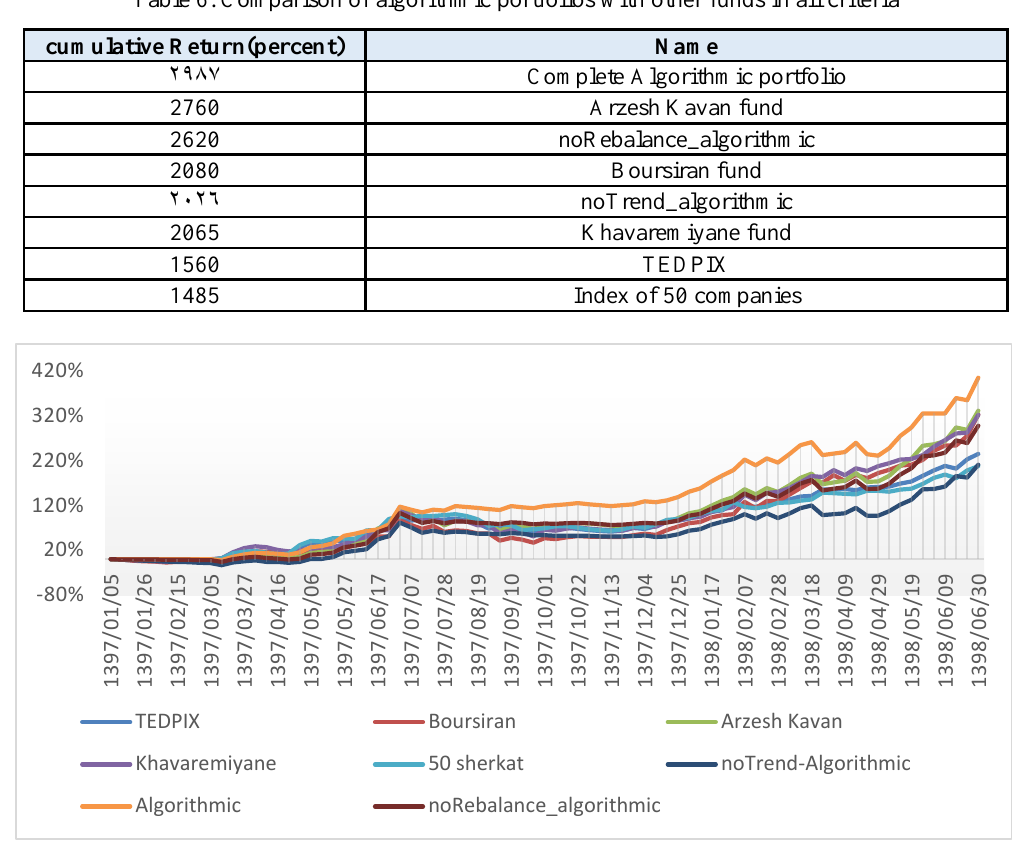
Figure 6.2 Comparison of return on net asset value from 1397/01/01 to